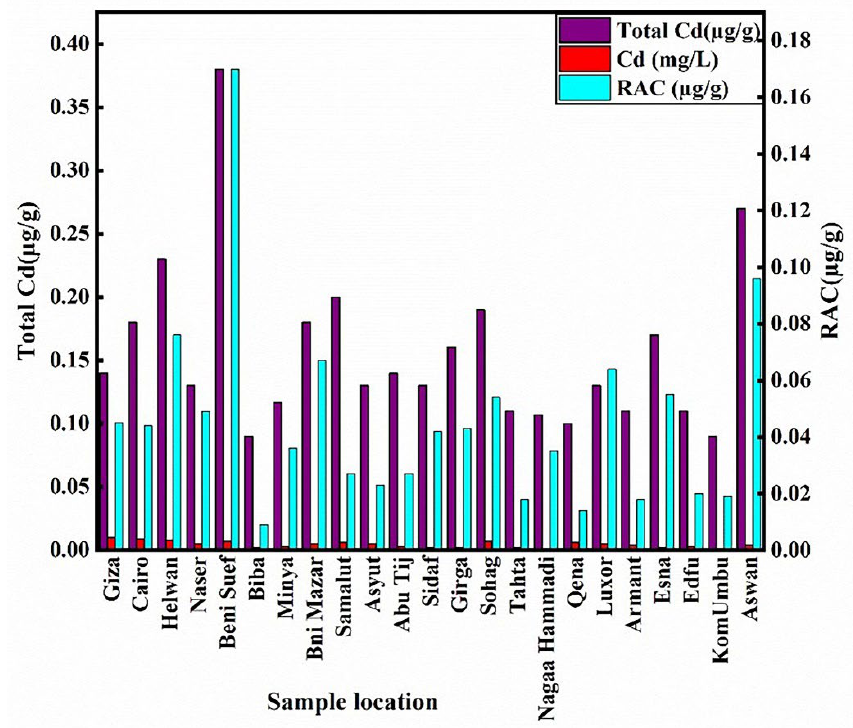
Figure 9. Relation between Concentration of Cd in sediments (mg kg − 1 ) mg kg − 1 and Water mg L − 1 with risk assessment code (RAC) (mg kg − 1 ) of samples along Nile River - mainstream.